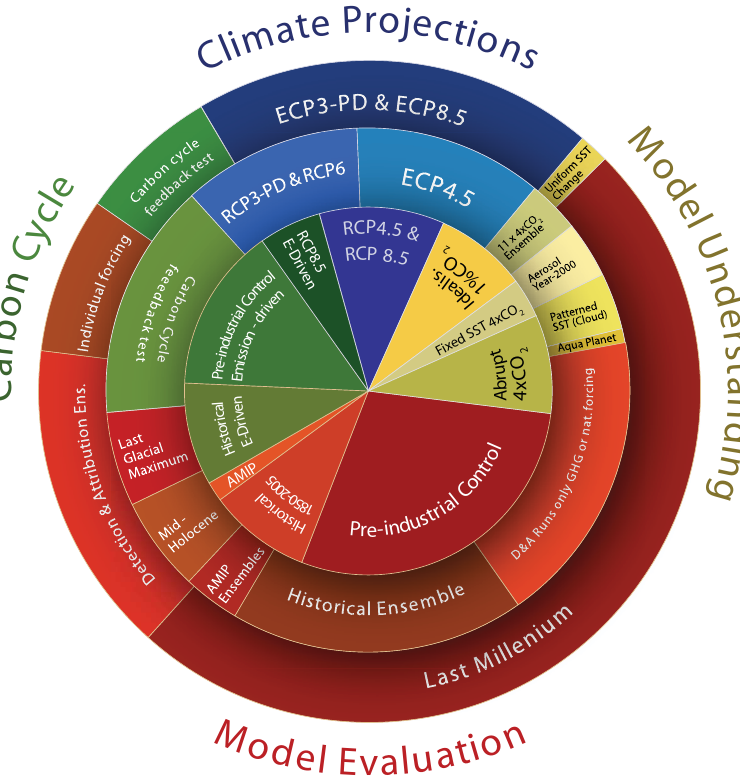
Fig. 1. Schematic of CMIP5 centennial simulations, adapted from Taylor et al. (2009) with each experiment being represented by an area that is proportional to the experiment’s length in model years. The inner circle denotes “core” priority experiments with tier 1 (middle circle) and tier 2 (outer circle) having successively lower priority. Experiments are split between climate projections (blue), idealised experiments aimed at elucidating process understanding in the models (yellow), model evaluation, including pre-industrial control runs and historical experiments (red), and additional experiments for models with a coupled carbon cycle (green). See CMIP5 project webpage (Appendix A) for more detailed information. (D&A: detection and attribution, ECP: extended RCP simulations to